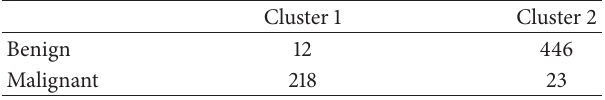
Table 3: Comparative clustering results for Wisconsin breast cancer dataset.